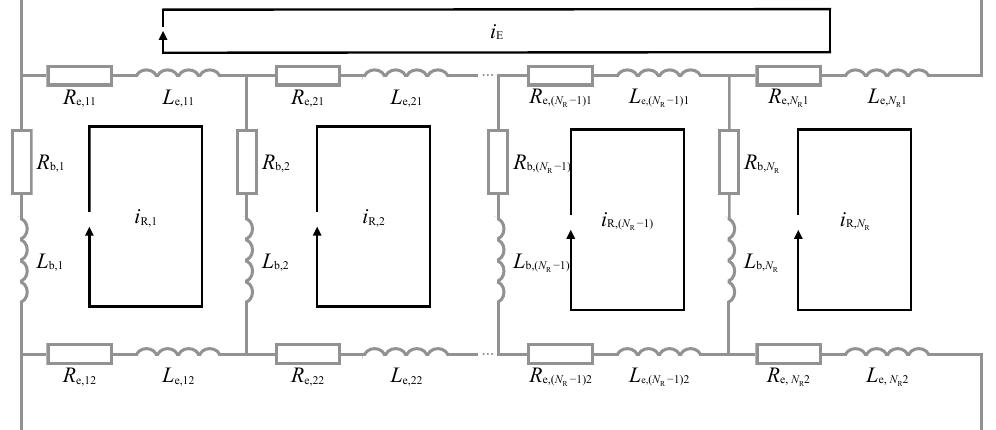
Figure 1. Electrical network of a rotor of a squirrel cage induction motor with the individual loop currents i R , end ring current i E , and associated resistances R e and R b , as well as leakage inductances L e and L b of cage bars and end ring